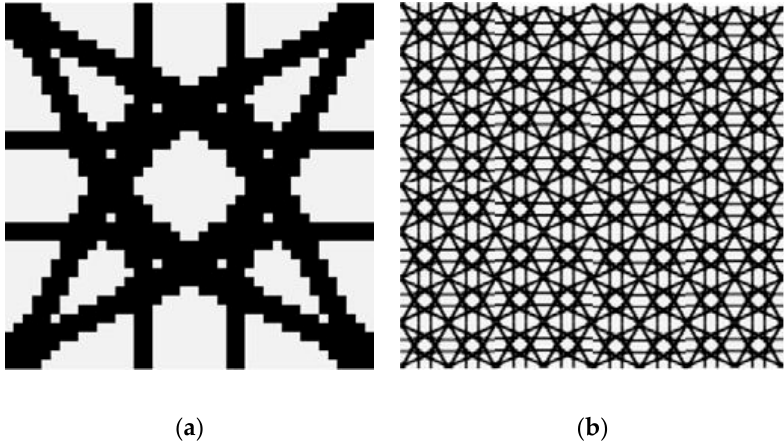
Figure 16. Design and optimal material [181]: ( a ) optimal unit cell; ( b ) lattice structure.